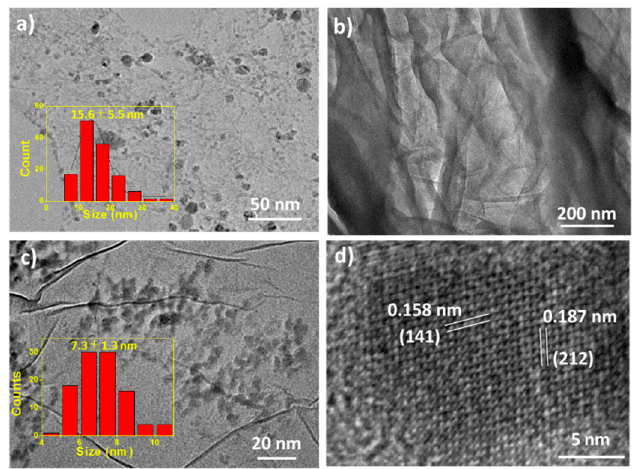
Figure 1. ( a ) A TEM image of free Ag 2 S crystals, inset: a particle size distribution histogram. ( b ) A TEM image of a GO sheet. ( c ) A TEM image on Ag 2 S/rGO, inset: a histogram of the particle size distribution of Ag 2 S crystals. ( d ) A high-resolution TEM (HRTEM) image of the Ag 2 S/rGO.